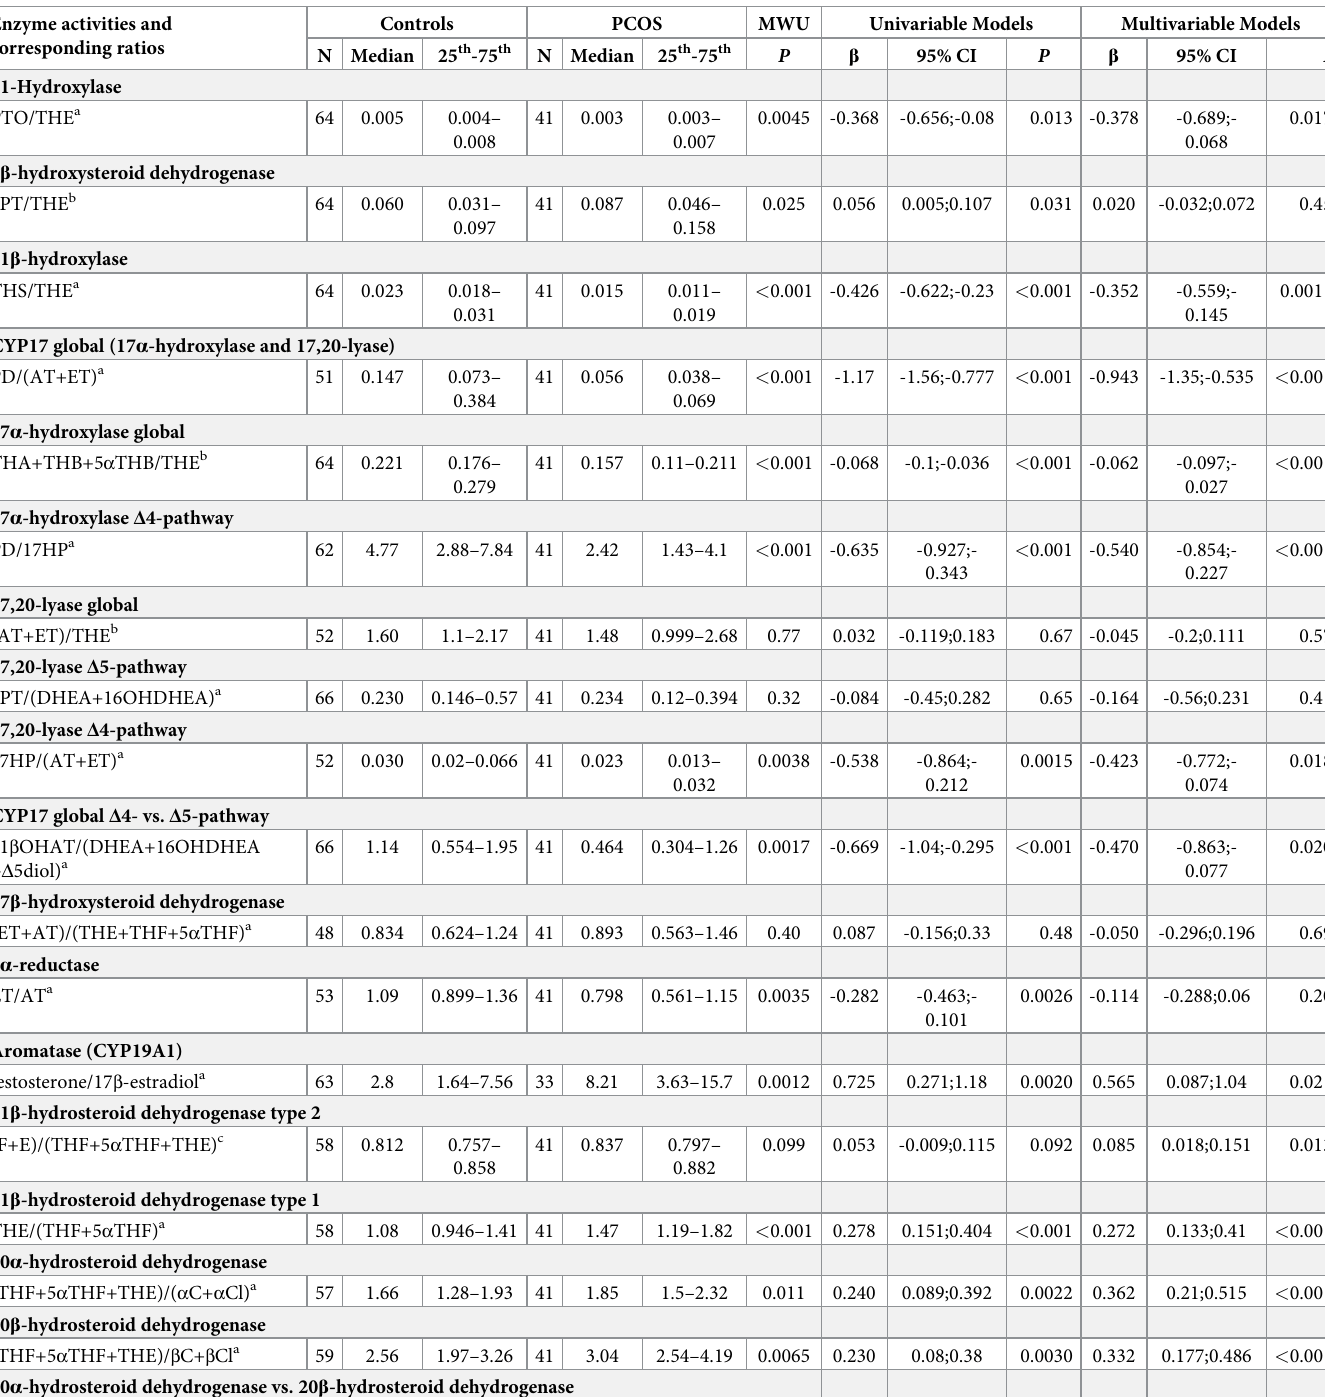
Table 2. Steroid hormone enzyme activities represented by selected steroid hormone metabolite ratios in women with polycystic ovary syndrome compared to healthy women. The available number of participants (N) and median and 25 th -75 th quantile are indicated. Between-group differences are determined by Mann–Whitney U test (MWU). Univariable and multivariable models are calculated by linear regression with transformed steroid hormone metabolite as dependent variable. Univariable models contain the PCOS group as predictor variable (with controls as reference group). Multivariable models contain in addition the covariables age and BMI. The β coef- ficients and the corresponding 95% confidence intervals (CI) are reported on the transformed scale. Note that only significant different ratios are shown here, while the results for all calculated steroid hormones ratios are displayed in S3